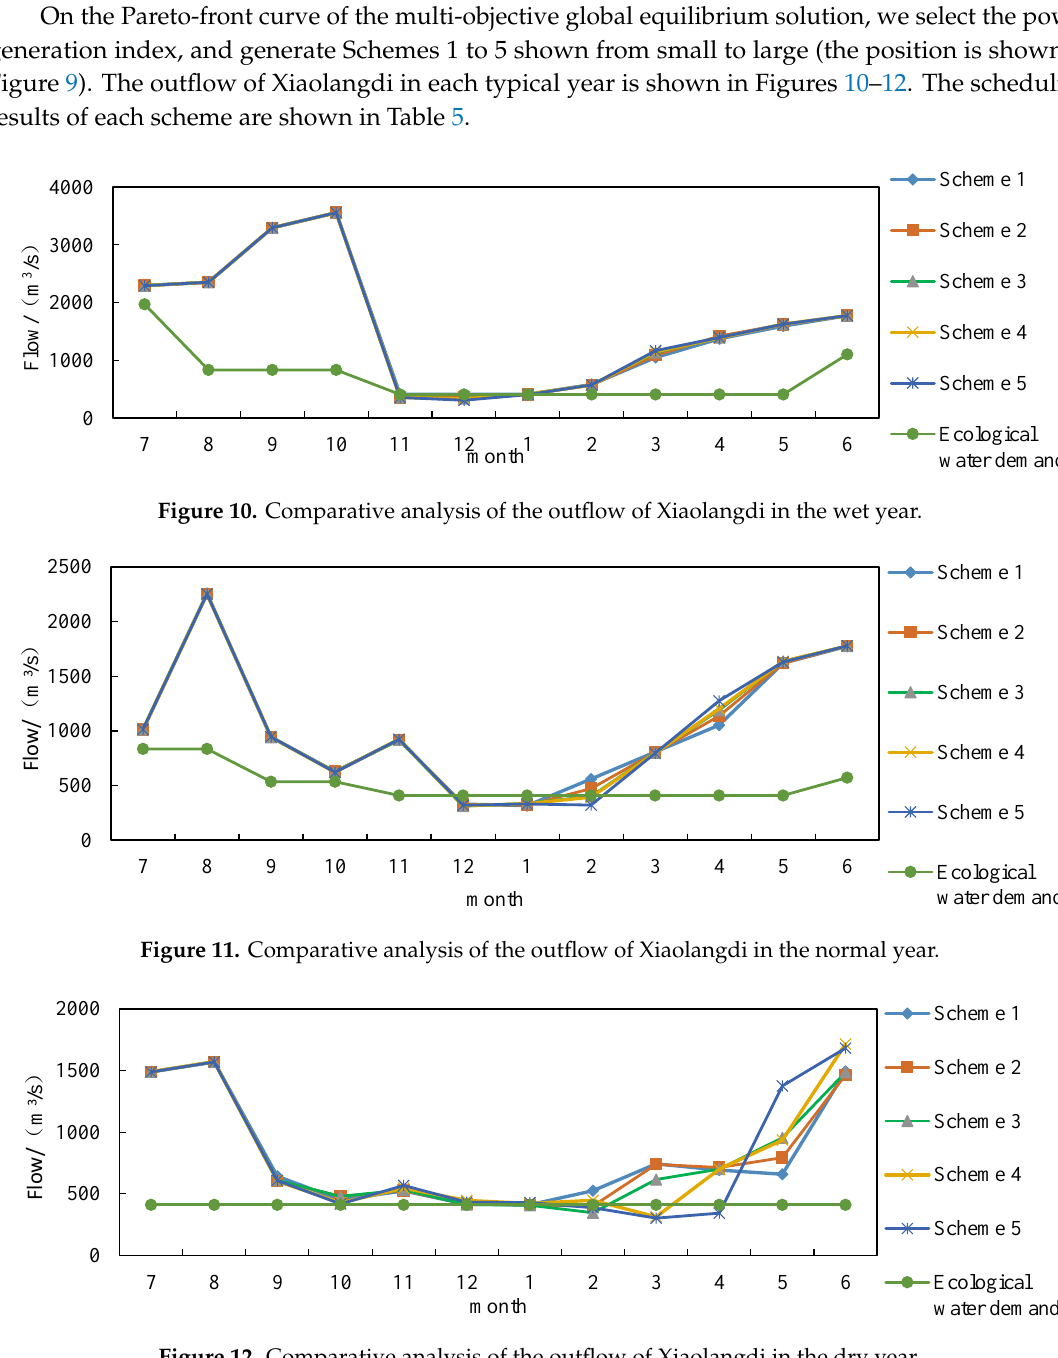
Table 5. Comparative analysis of various schemes in typical years.